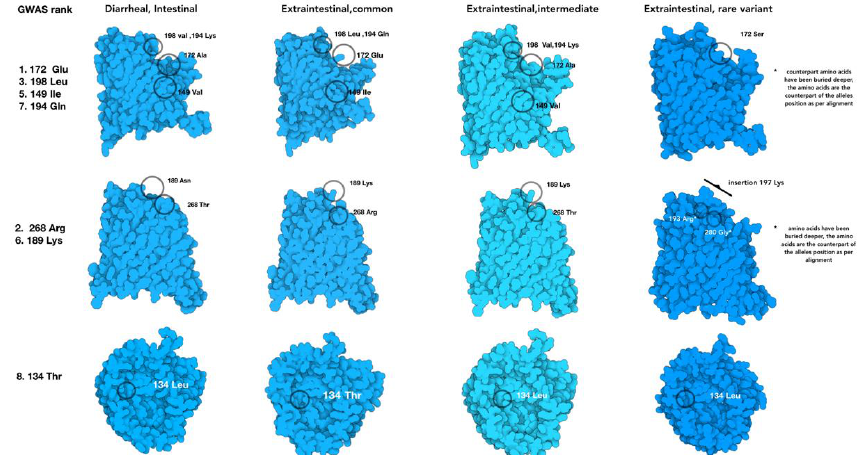
Figure 5. Protein models of the four groups of porA allelic variants that change the PorA protein model structure relative to the isolate location in the host and the disease outcome. The amino acids corresponding with the BioML top-ranked alleles are labeled in the common variant of PorA, while the rest show the substituted amino acid in their respective position.